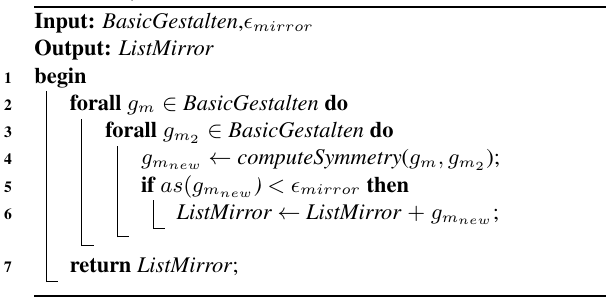
Algorithm 2: calculateMirror (Searching for maximal meaning- ful mirrors)